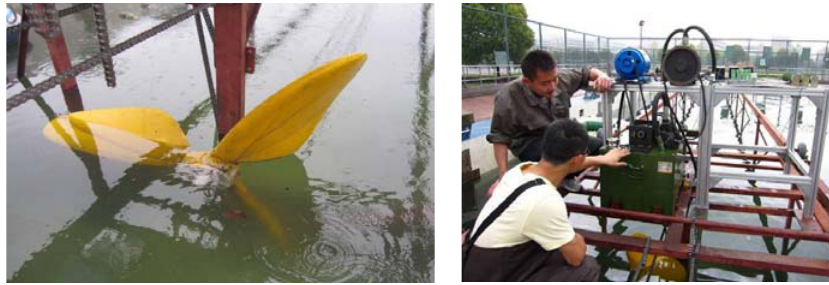
Figure 13. Blade performance test experiment.